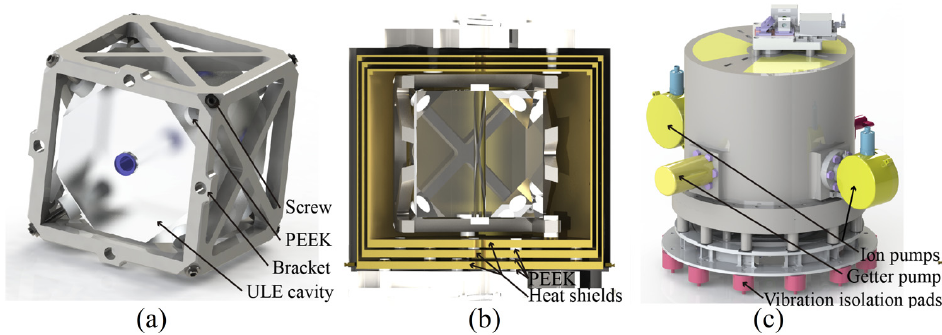
Figure 2. Model of mounting system for the FP cavity showing: ( a ) cavity with bracket, ( b ) cross- sectional view, and ( c ) overall system.